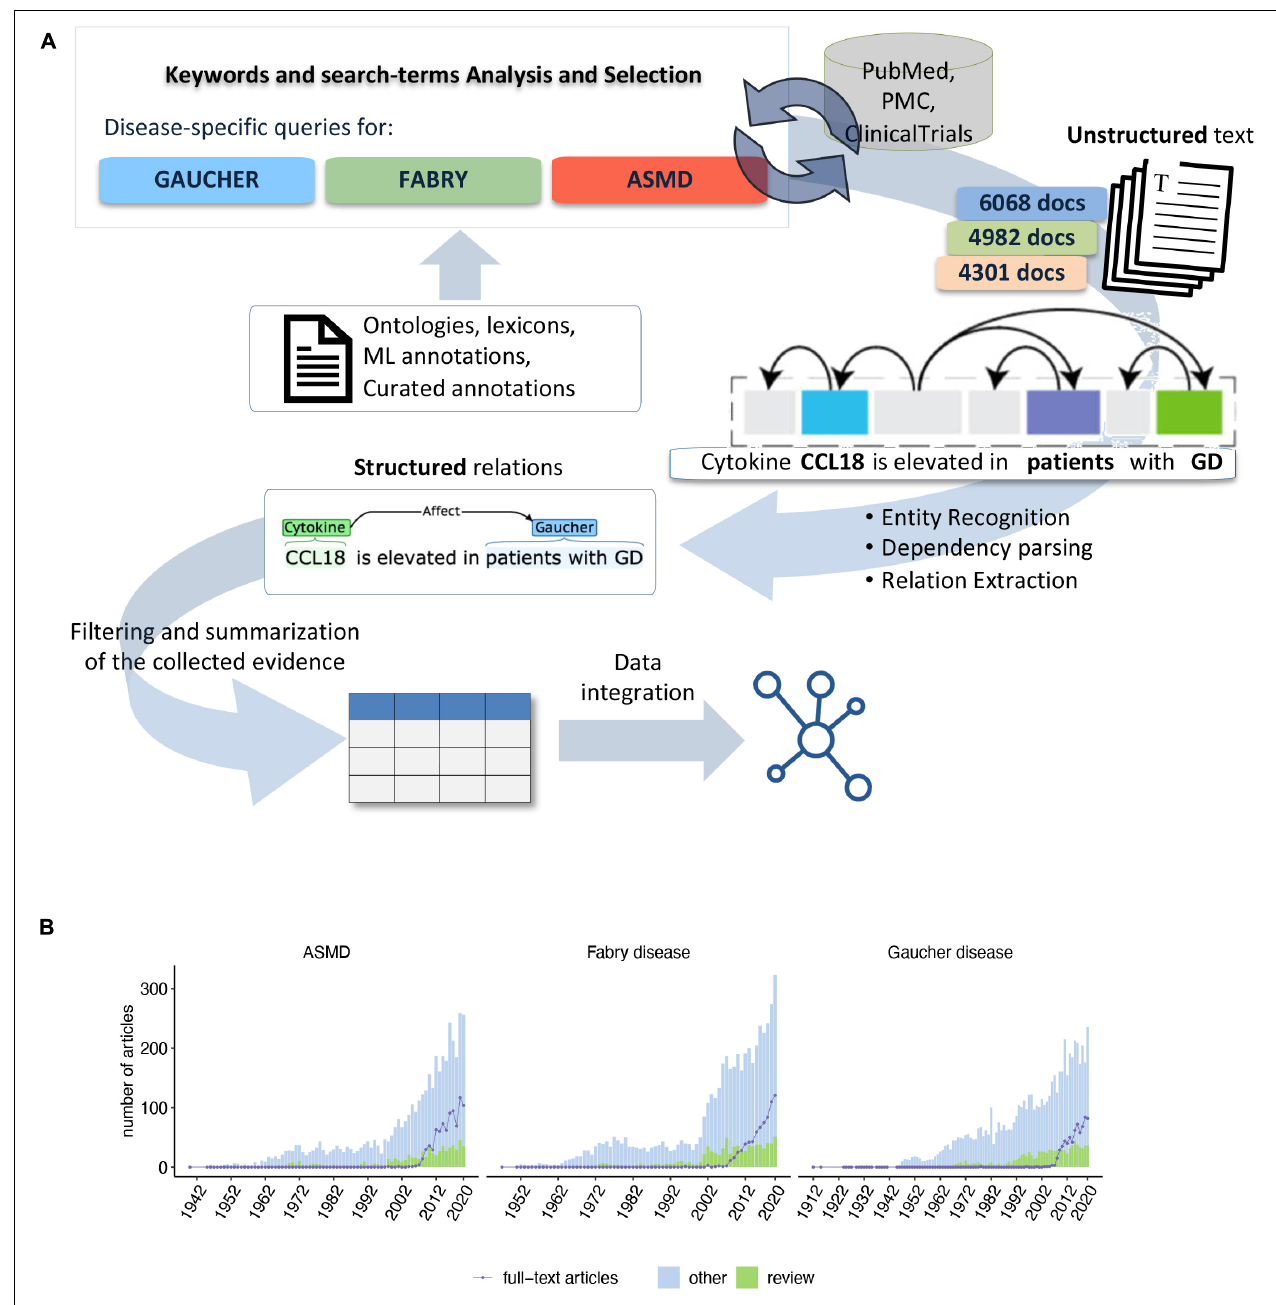
FIGURE 1 | (A) Overview of the text-mining pipeline: Ontologies, DBs, and ML annotations were used to select specific queries and search terms on PubMed, PMC for the three diseases. Over 15,000 documents were retrieved and processed with our NLP-based analytics platform. The structured knowledge derived from the linguistic relationship extraction was normalized, analyzed, and integrated with biological databases to derive a systems outlook of the inflammatory signal. (B) Summary of the disease-specific scientific literature we analyzed to identify the cytokines. For each disease is shown the number of articles per year of publication. The number of review articles is highlighted in green. The violet line shows the number of full-text articles available for